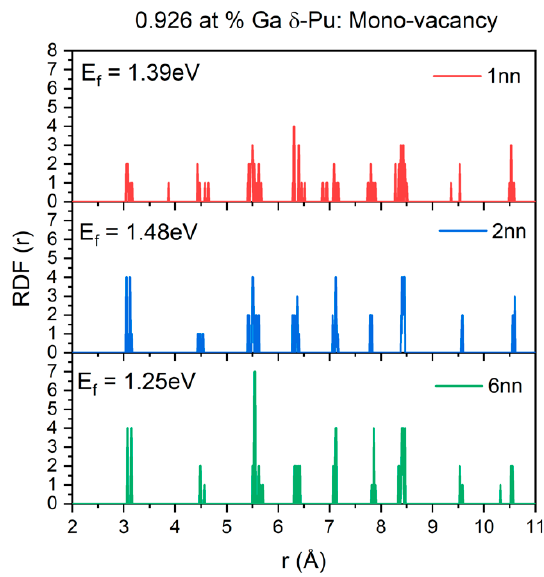
Figure 5. Radial distribution function (RDF) of a mono-vacancy from first (1nn), second (2nn), and sixth (6nn) nearest neighboring distance from the Ga atom for 0.926 at. % Ga. RDF is calculated from the perspective of the Ga atom.